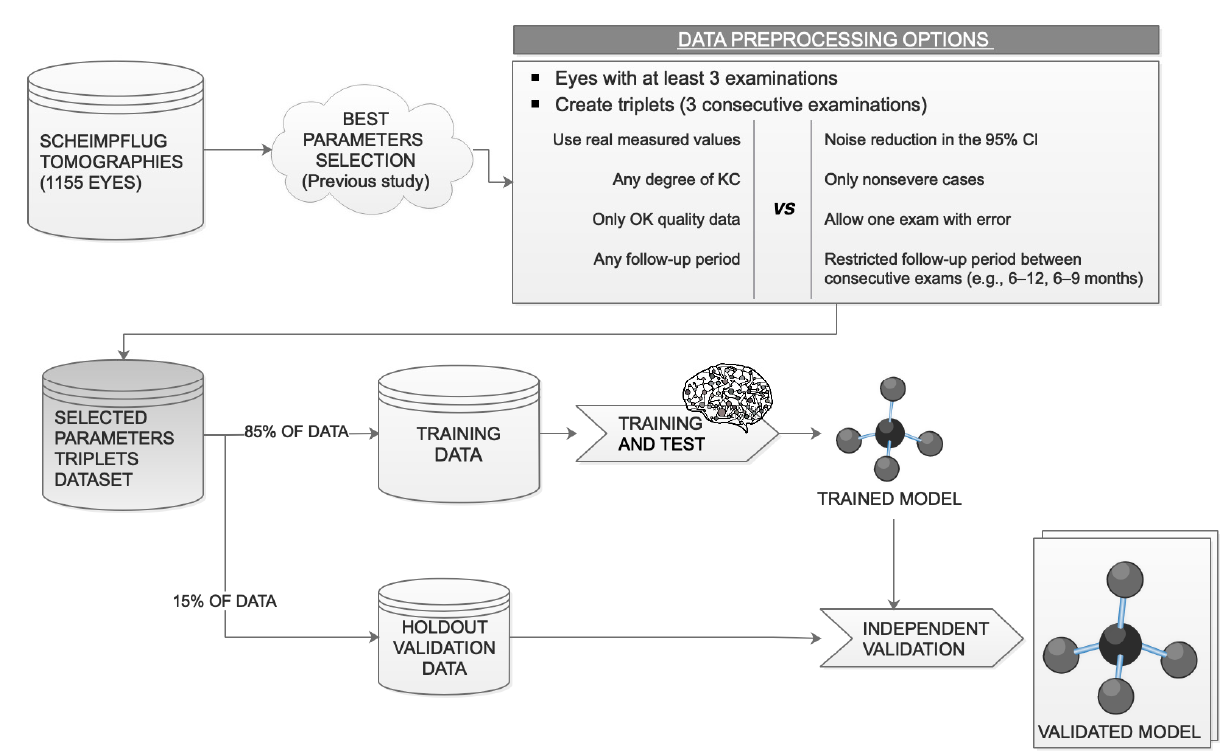
Figure 3. Data usage. After the data preprocessing, 85% of the data are used for training and 15% are kept for an independent holdout validation of the trained model. KC, keratoconus; 95 CI, 95% confidence interval.